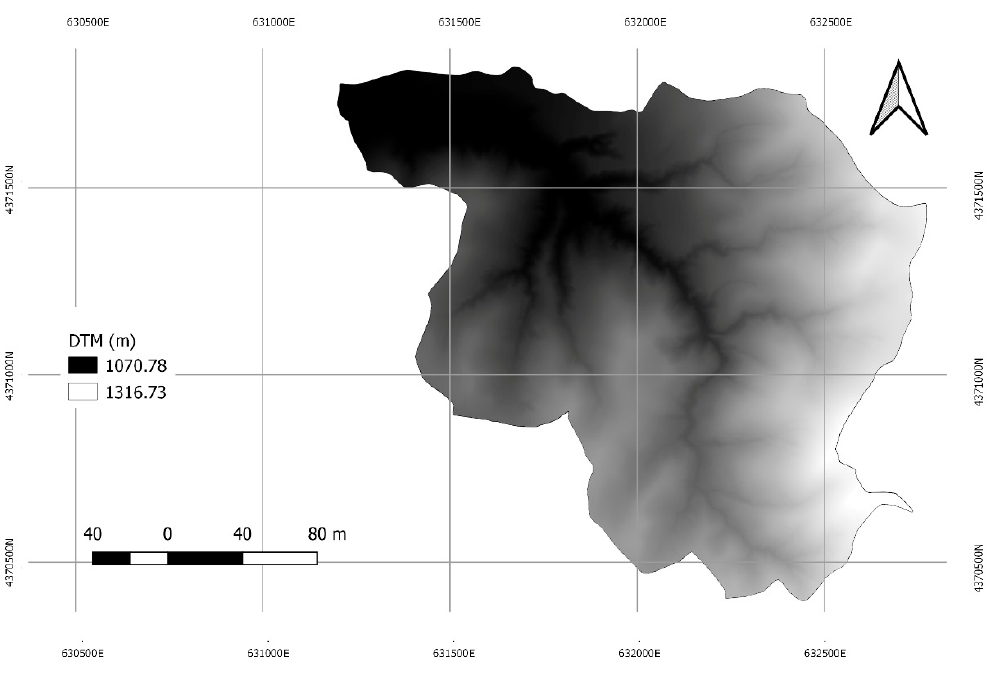
Figure S5. Digital terrain model of the study area.